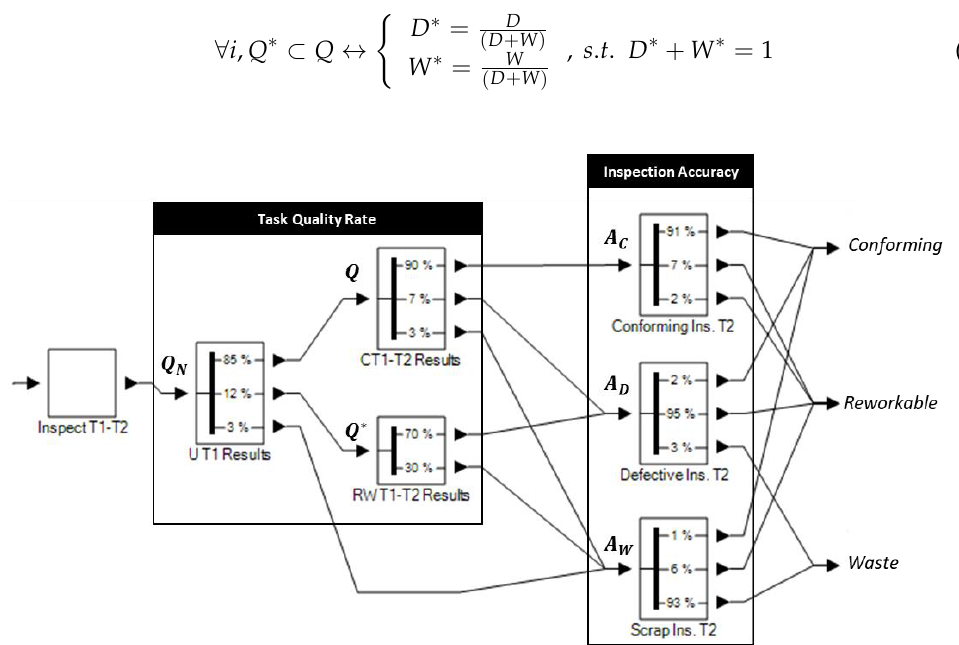
Figure 4. Example of modification to the DES model of an inspection process when a previous defect had not been inspected.